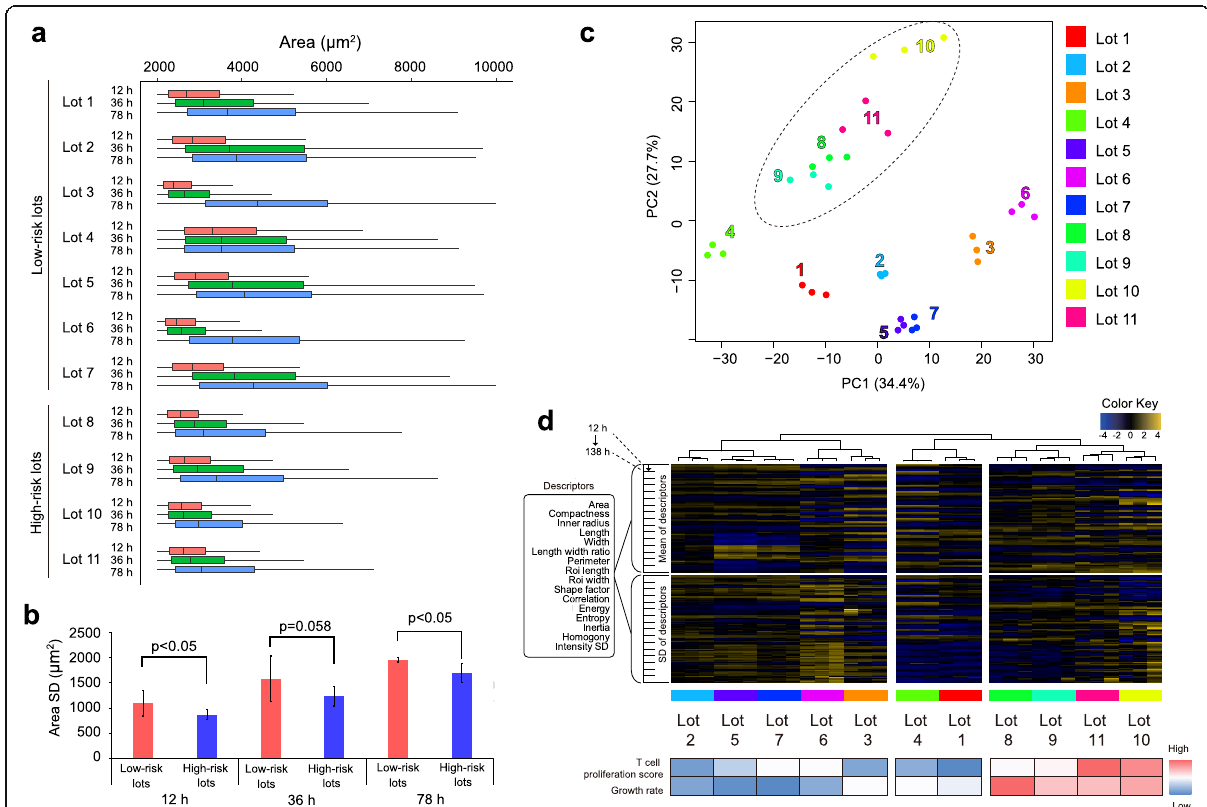
Fig. 3 Morphological profile analysis of 11 lots of MSCs. a Early time-course transitions of “ area ” distribution comparing 11 lots. Low-risk lots: Lots 1 – 7, High-risk lots: Lots 8 – 11, categorized by the T-cell proliferation inhibitory potencies. b Comparison of SDs of “ area ” among Low-risk lots and High-risk lots at 12, 36, 78 h at their early time-course. Asterisks indicate p < 0.05 by Student ’ s t -test. c PCA mapping of 11 lots by morphological profiles. Each lot is depicted with the same color dots (3 wells). Dotted circle indicates the cluster of High-risk lots. d Hierarchical clustering of 11 lots by morphological profiles. Columns consist of 3 wells × 11 lots, and rows indicate morphological profiles (32 parameters × 22 time points). The heat map under the clustering tree shows their measured potencies (T-cell proliferation score, and growth